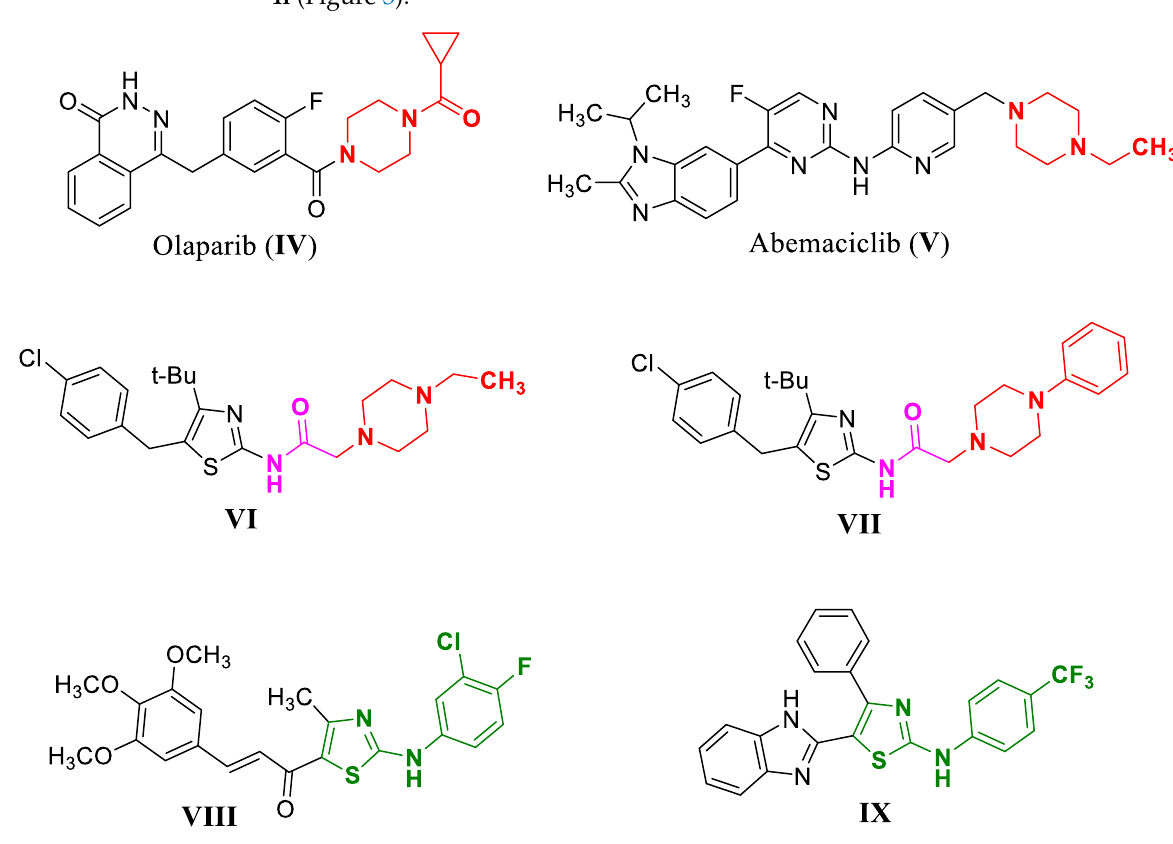
Figure 2. Structures of piperazine-bearing compounds and ( IV – VII ) aryl aminothiazole-bearing compounds ( VIII and IX) with anticancer activity.